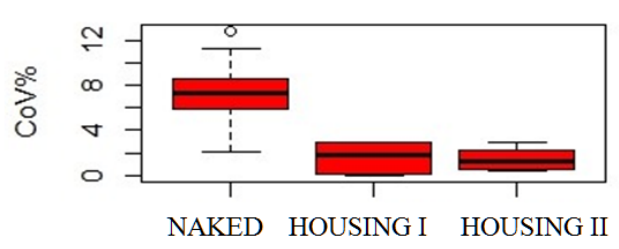
Figure 5. Coefficient of variation (CoV) of the responses to 40 kg loading with pucks of different materials in the different sessions. Error bars represent 95% confidence intervals.